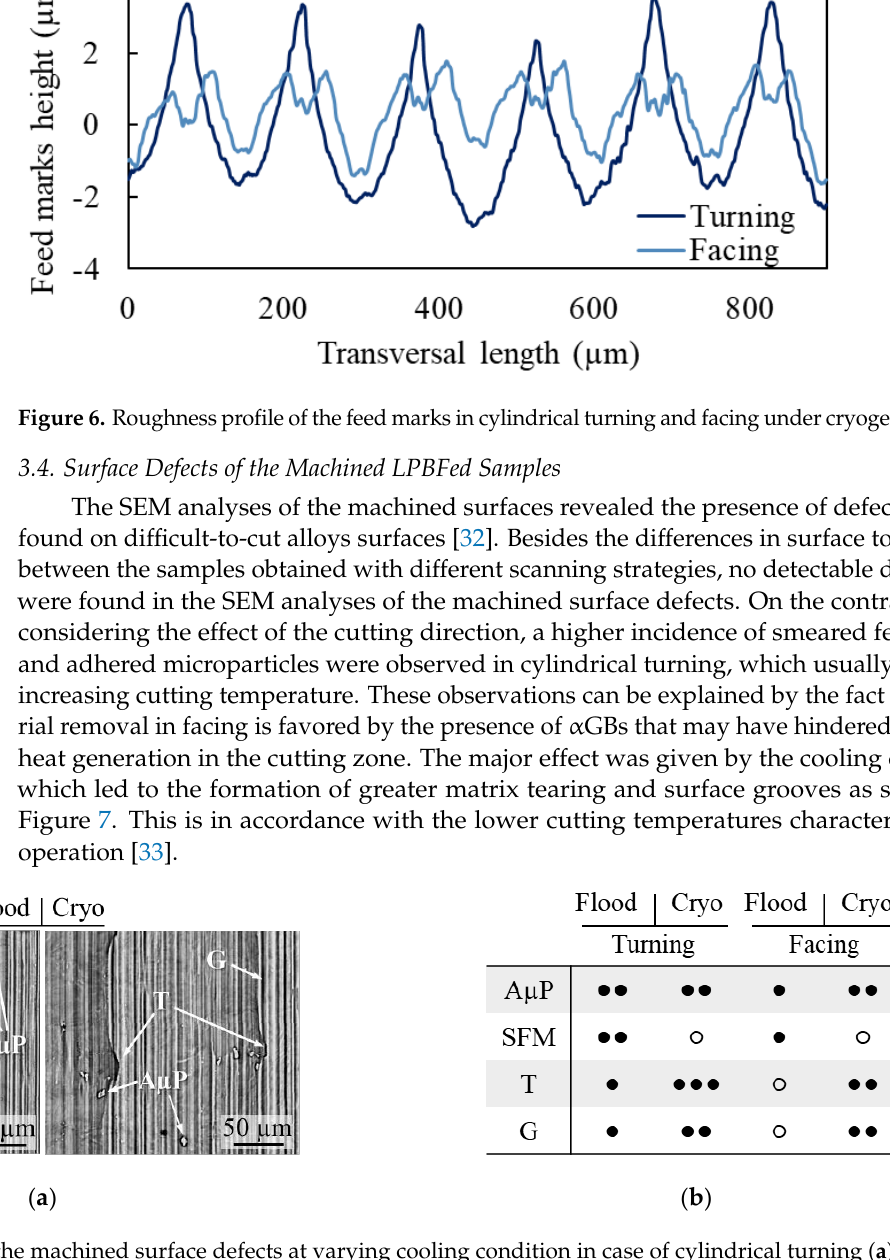
( b ) Figure 7. SEM images of the machined surface defects at varying cooling condition in case of cylindrical turning ( a ). The table ( b ) reports the summary of the defect entity charts (A µ PM: adhered microparticles; SFM: smeared feed marks; T: tearing; G: grooves).